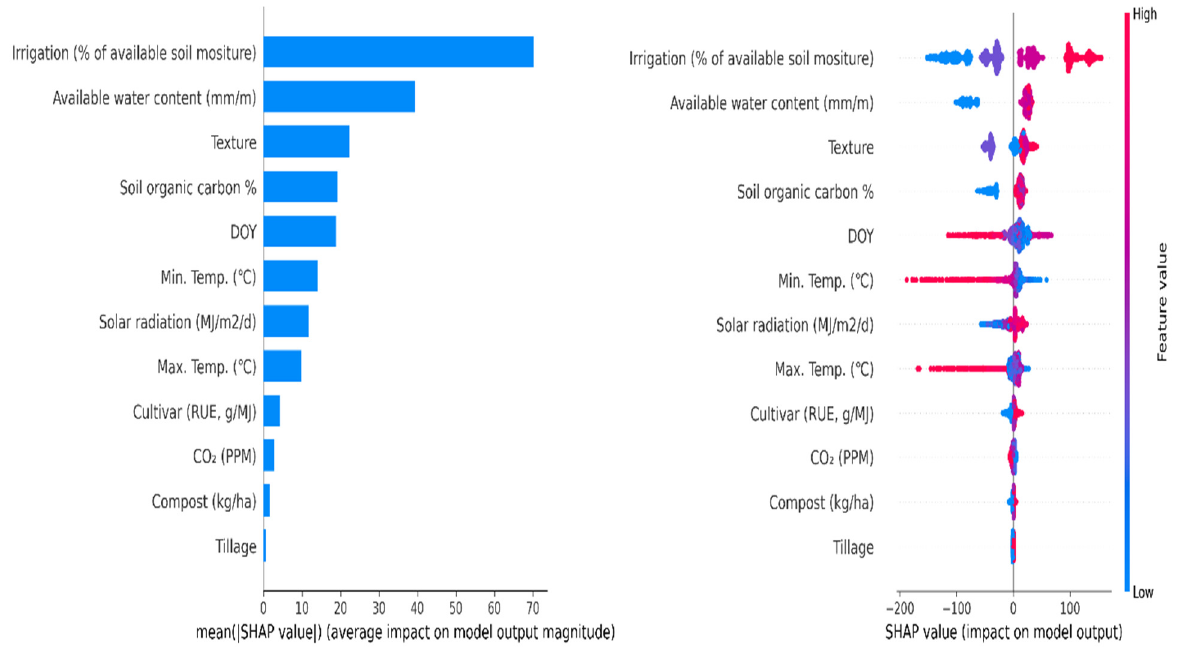
Figure 8. Feature importance for ET (mm) based on SHAP-values for the XGBoost regression model. On the left , the mean absolute SHAP-values are depicted to illustrate global feature importance. On the right , the local explanation summary shows the direction of the relationship between a feature and the model output. Positive SHAP-values are indicative of increasing grain yield whereas negative SHAP-values are indicative of decreasing grain yield.